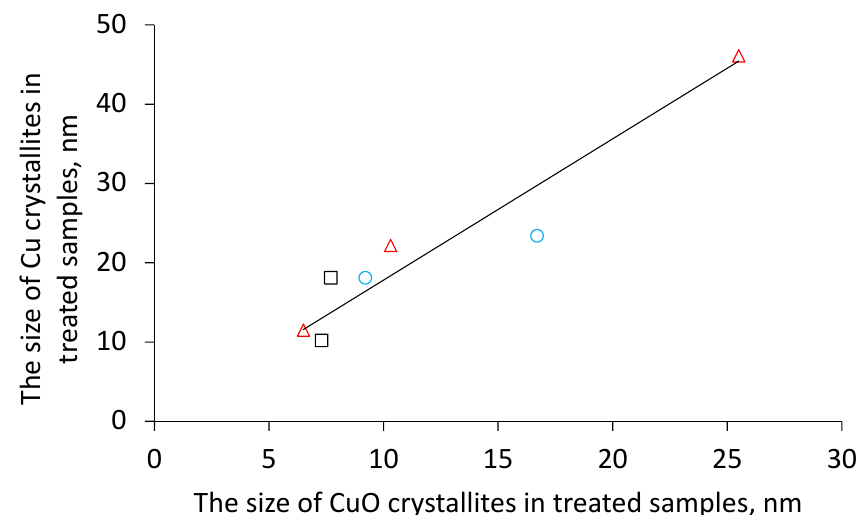
Figure 4. A relationship between the CuO and Cu crystallites size in catalyst samples prepared by calcination in air ( □ ), nitrogen ( ∆ ) and hydrogen ( ○ ) at different temperatures.